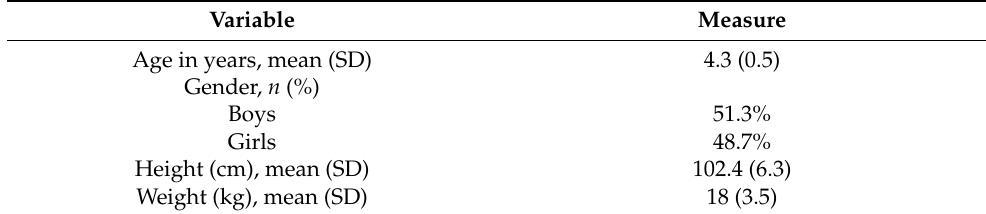
Table 1. Characteristics of preschool children (N =